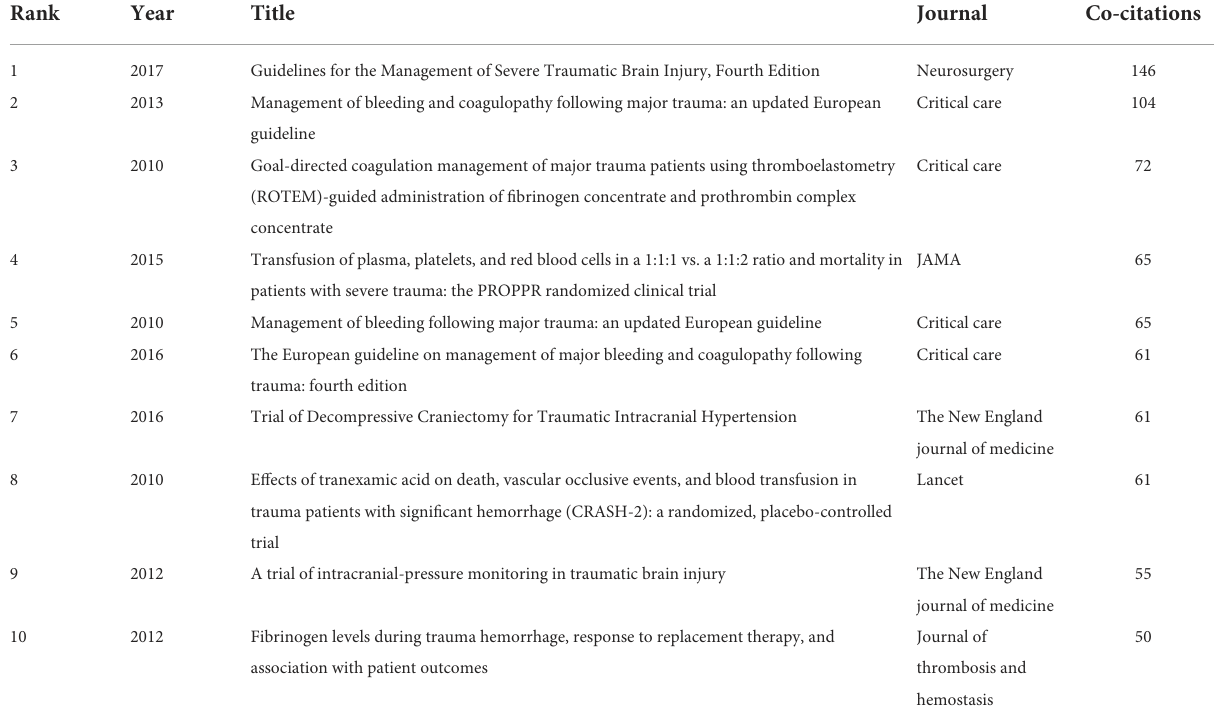
severe traumatic brain injury, #1 traumatic coagulopathy, #2 resuscitative endovascular balloon occlusion, #3 hemotherapy algorithm, #4 fibrinogen concentrate, #5 pediatric traumatic brain injury, #6 whole-body computed tomography, and